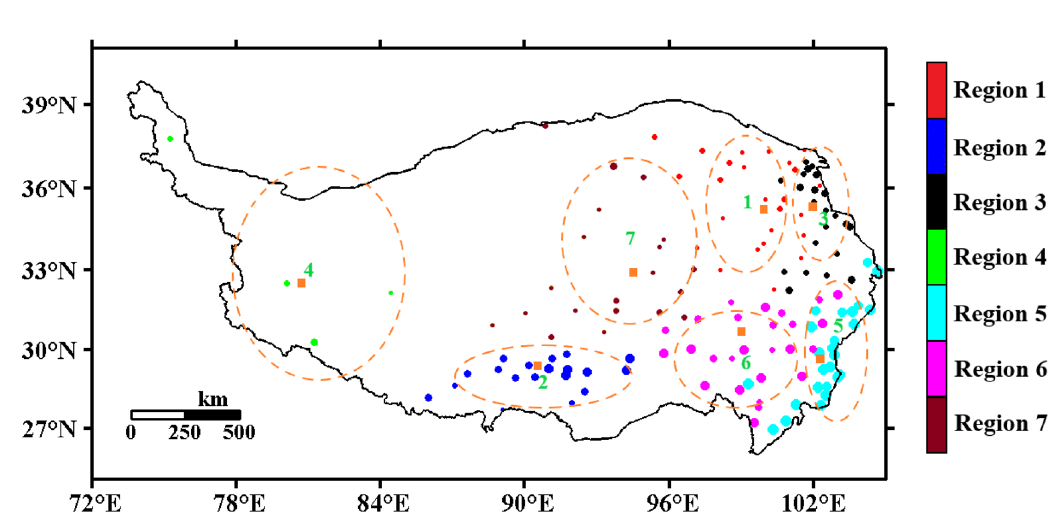
Figure 8. The 20 cm ST division of the Qinghai-Tibet Plateau (7 regions). The points are divided into four categories, from small to large: < 6 °C (cold region), 6–11 °C (subcold region), 11–16 °C (subwarm region), > 16 °C (warm region) (Software: MATLAB 2014, https:// ww2. mathw orks. cn/ produ cts/ matlab.